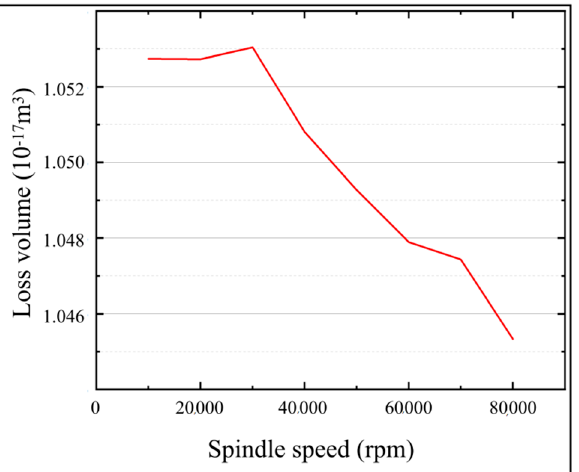
Figure 14. ( a ) T (0,0,0) variation with machining time at different spindle speeds; ( b ) T max variation with machining time at different spindle speeds.